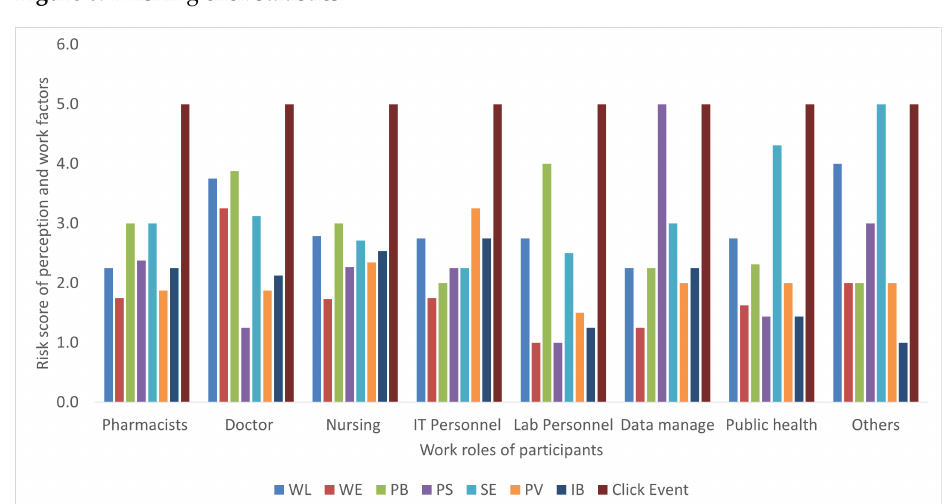
Figure 7. Comparing actual clicks with intended phishing behaviour of healthcare